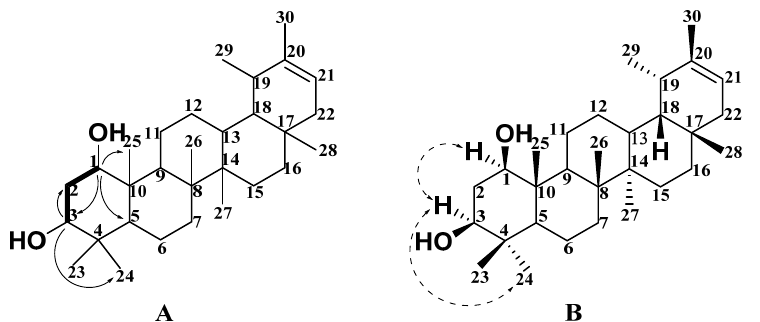
Figure 3. Key H-H COSY (bold), HMBC (plain arrow; ( A )), and NOESY (dash arrow; ( B )) correlations of compound 7 .